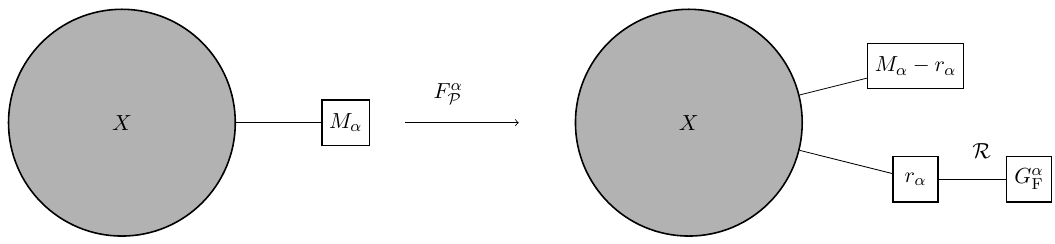
on a U( M ) subgroup of the global symmetry group of a α P